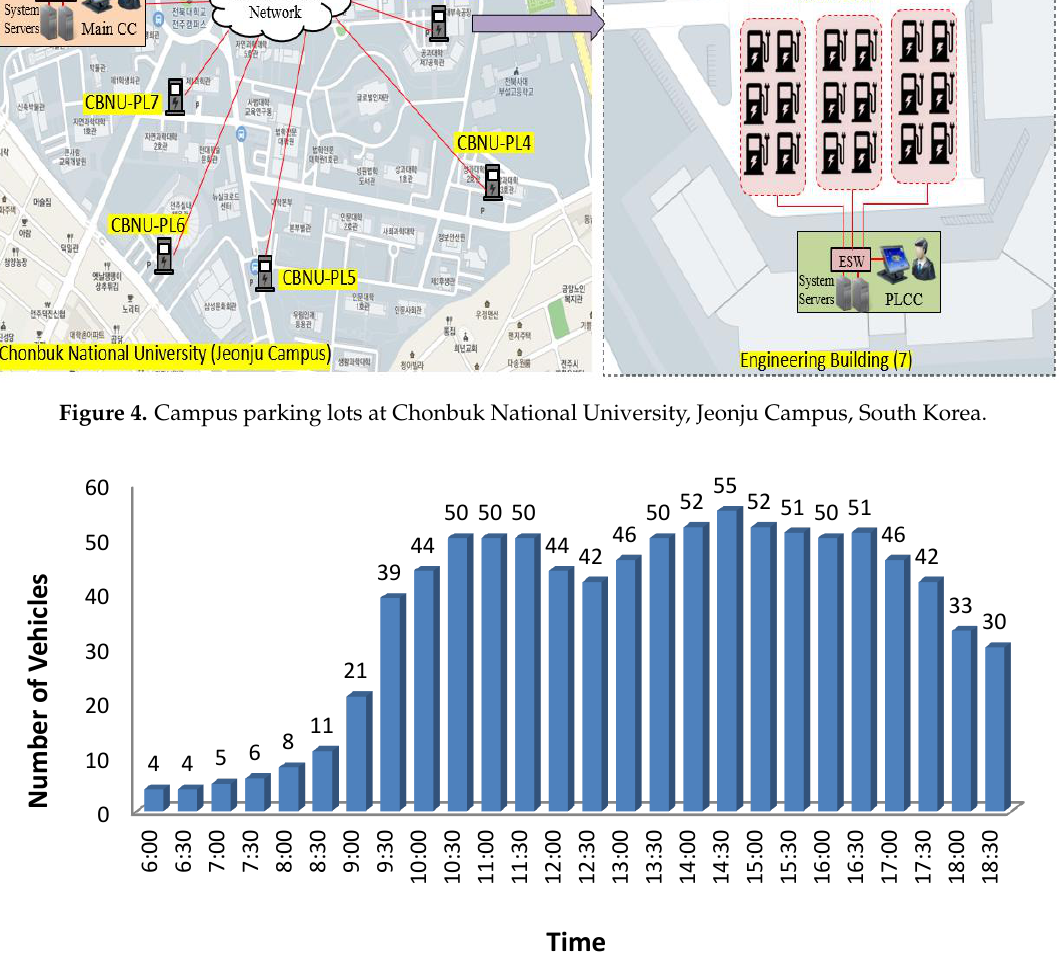
Figure 5. Typical parking utilization during weekdays (CBNU-PL3), 15 May 2018. Table 2. Electric vehicle specification.